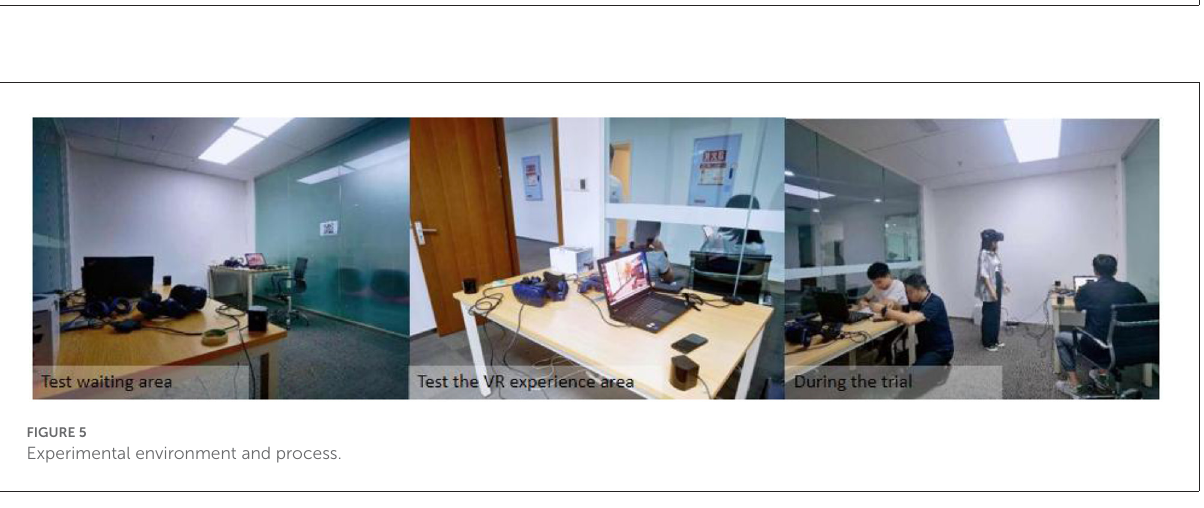
FIGURE5 Experimental environment and process.